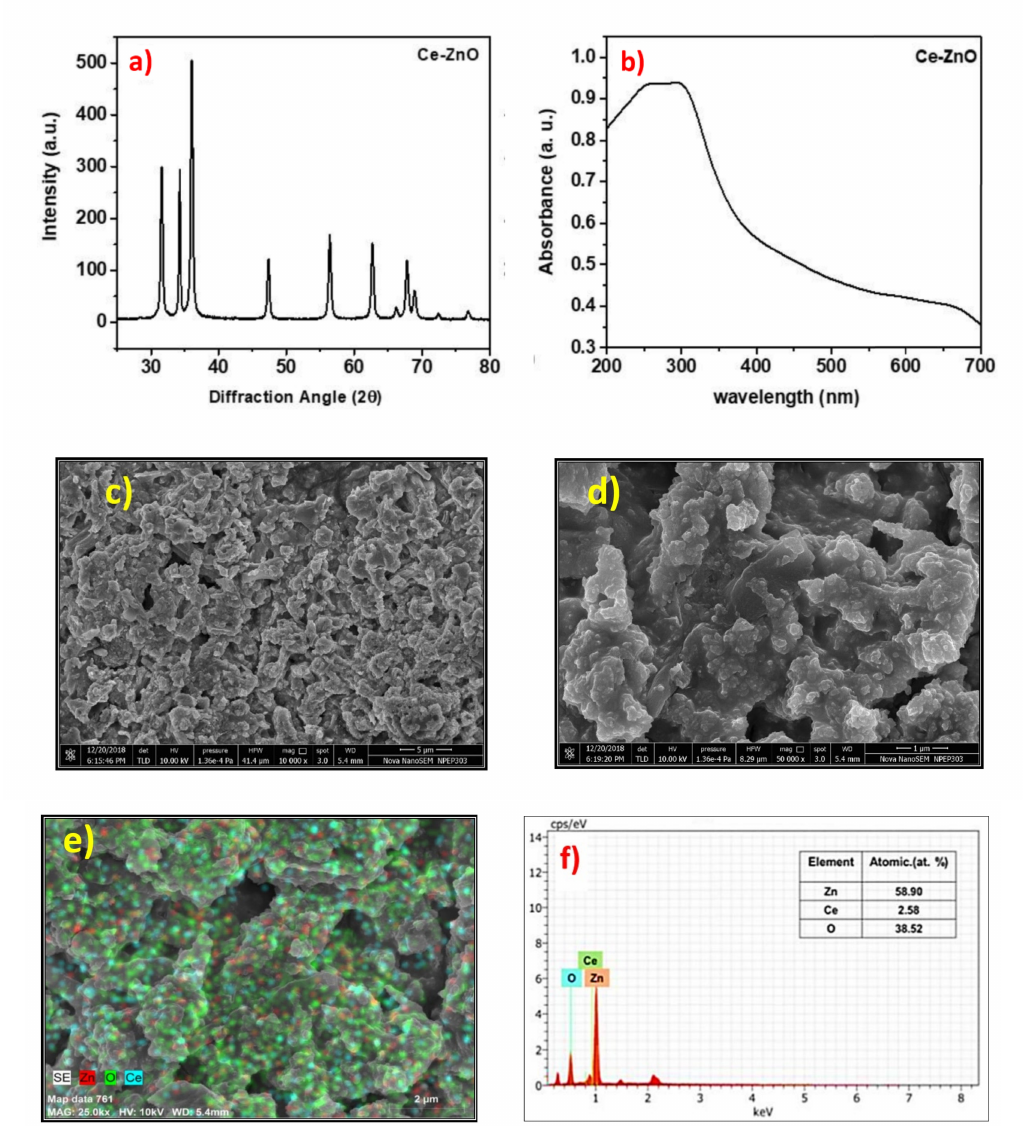
Figure 7. The characterization using: ( a ) XRD; ( b ) UV-vis; ( c ) FESEM (10000 × magnification); ( d ) FESEM (50000 × magnification); ( e ) EDS and ( f ) EDS